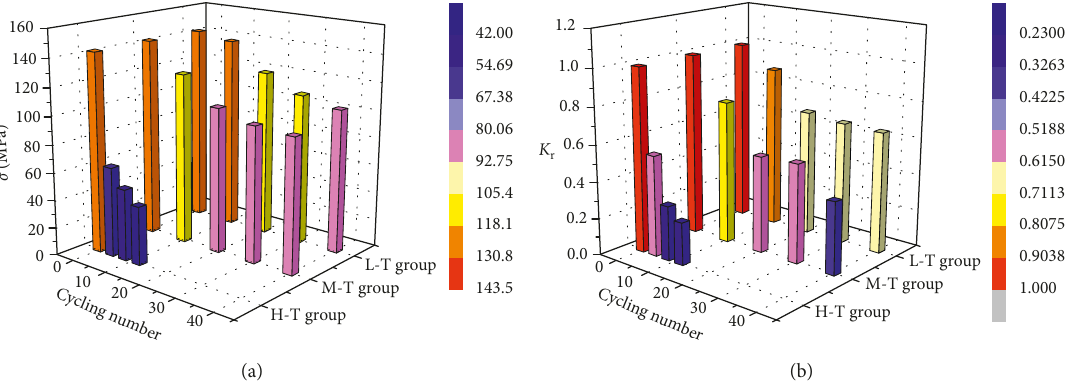
Figure 9: Effects of H-C cycles on peak stress and relative elastic modulus under different groups: (a) Relation of dynamic compressive strength with cycling number and (b) relation of relative elastic modulus with cycling